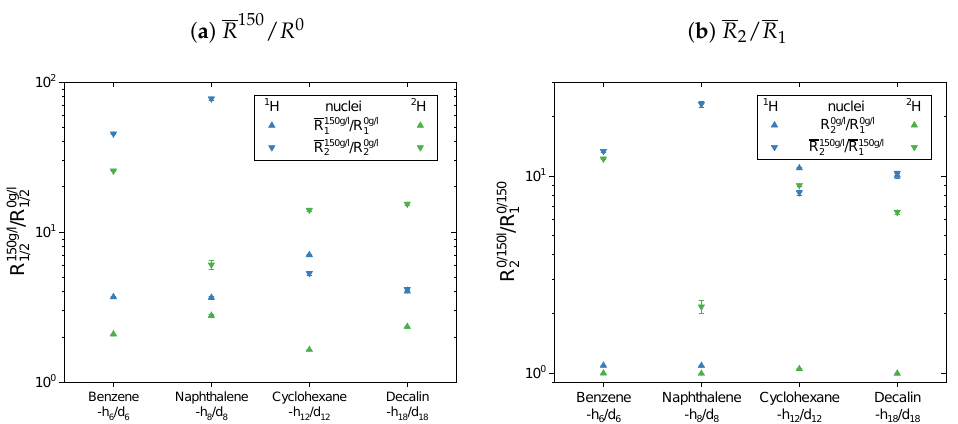
Figure 14. ( a ) Mean relaxation rate constants of the cyclic maltenes’ hydrogen isotopes in the asphaltenic solution normalized by the corresponding relaxation rate constants in the asphaltene-free solution, and ( b ) R 2 / R 1 ratio of the investigated cyclic maltenes’ nuclei in both solutions. The R 2 / R 1 ratios show then a similar trend for the aromatic and aliphatic nuclei.